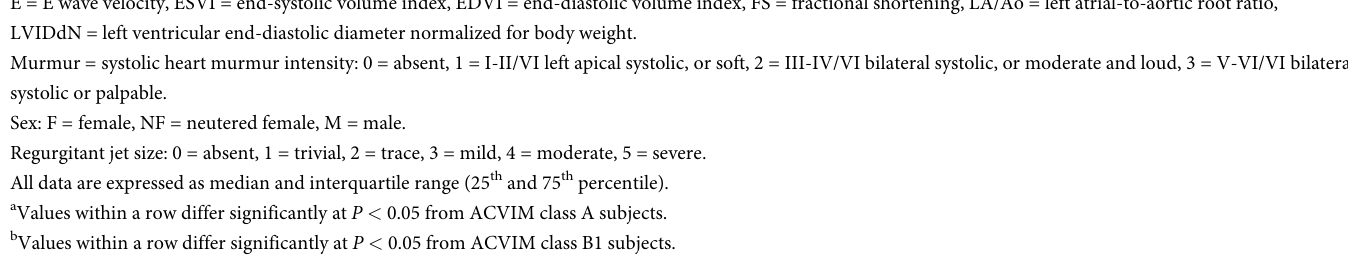
E = E wave velocity, ESVI = end-systolic volume index, EDVI = end-diastolic volume index, FS = fractional shortening, LA/Ao = left atrial-to-aortic root ratio, LVIDdN = left ventricular end-diastolic diameter normalized for body weight. Murmur = systolic heart murmur intensity: 0 = absent, 1 = I-II/VI left apical systolic, or soft, 2 = III-IV/VI bilateral systolic, or moderate and loud, 3 = V-VI/VI bilateral systolic or